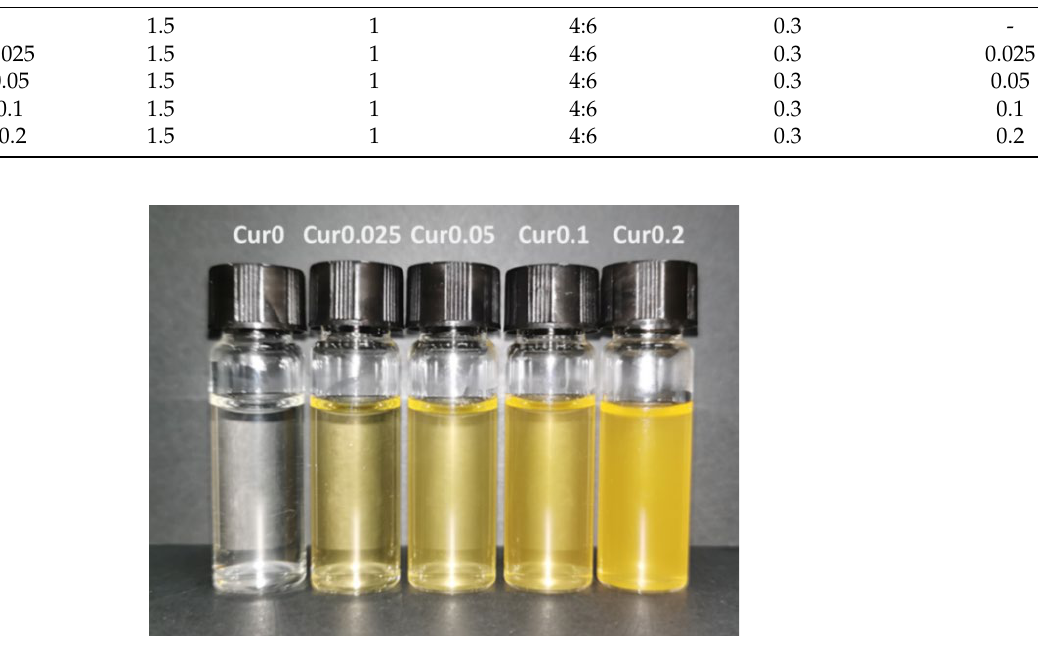
Figure 1. Film-forming solutions (FFSs) with different concentrations of Cur (prepared with a 4:6 mixture of GEL and